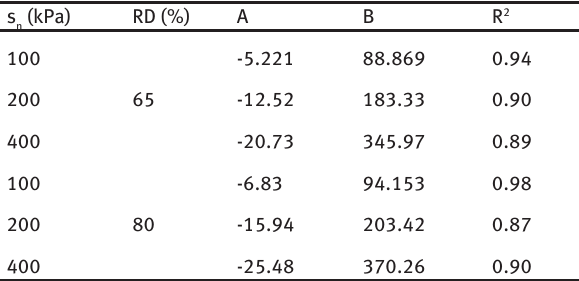
Table 5: Coefficients A, B and R 2 for equation